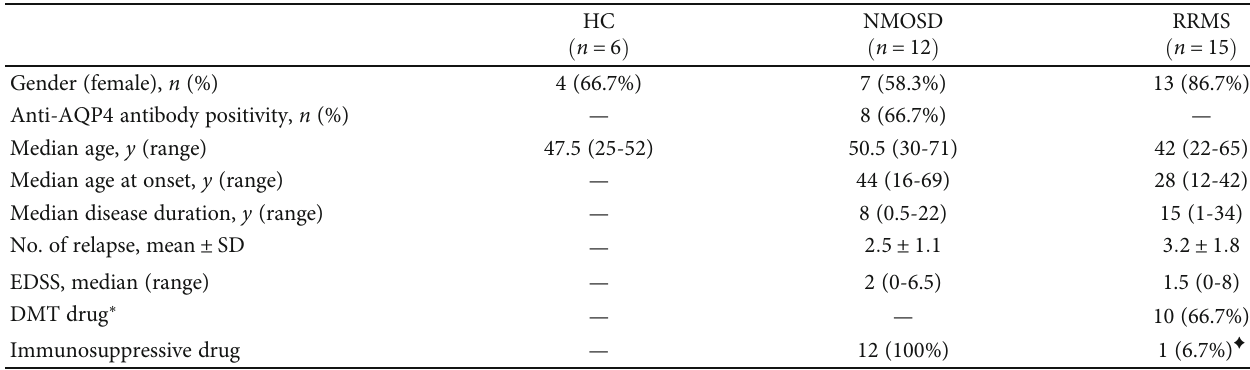
Table 1: Clinical characteristics of neuromyelitis optica spectrum disorder (NMOSD) patients, relapsing-remitting multiple sclerosis (RRMS) patients, and healthy controls (HC) involved in the